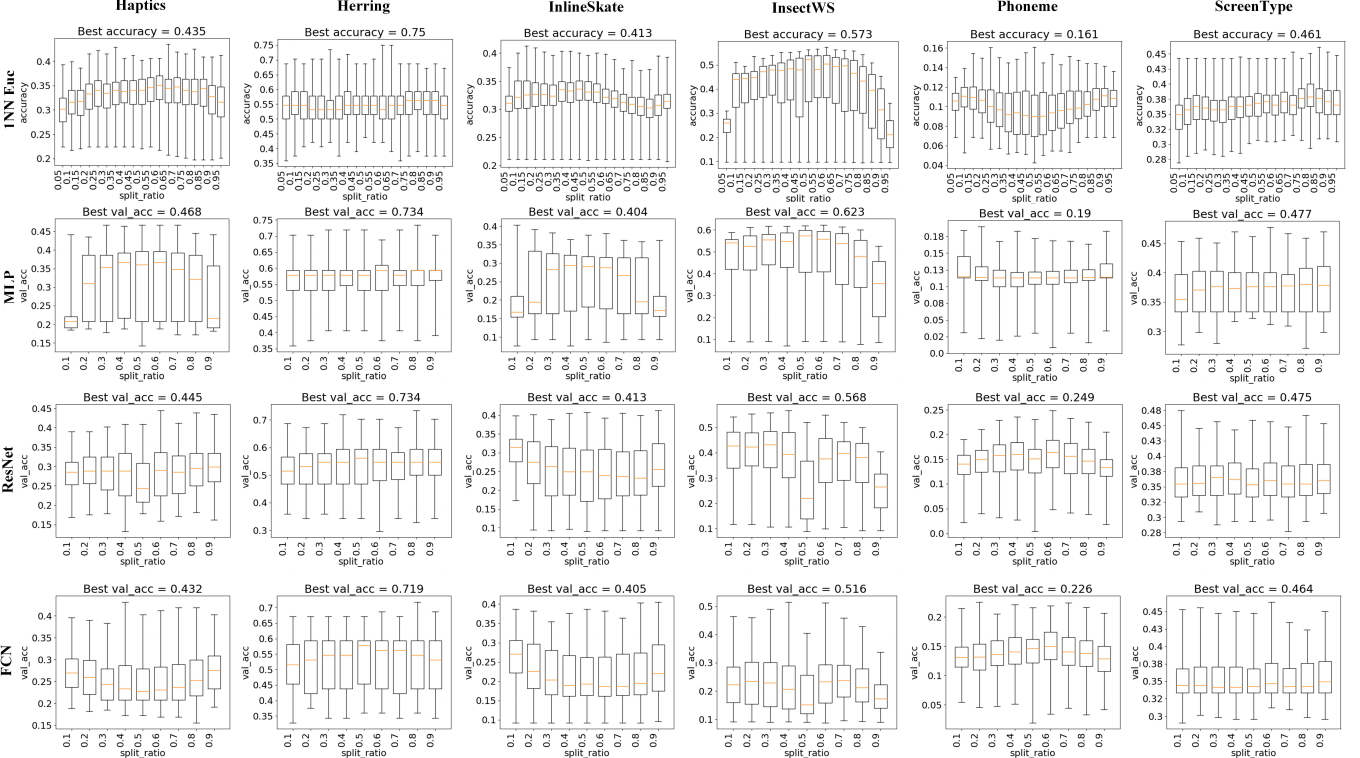
Figure 7. Impact of split ratio on TSC